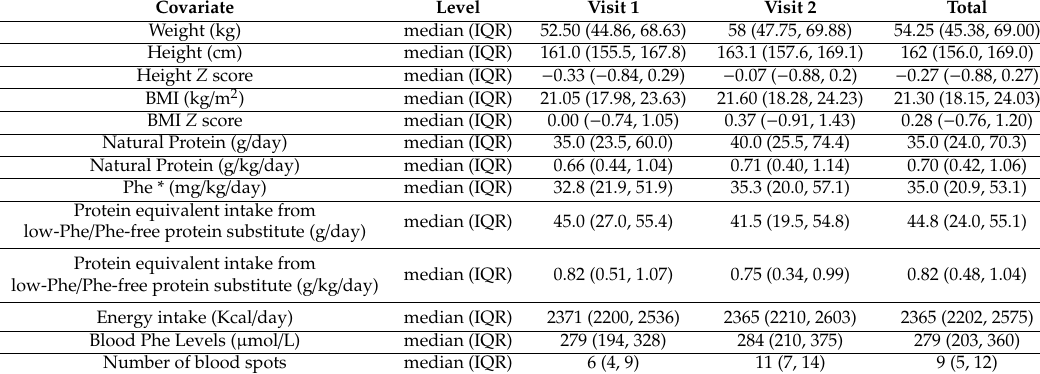
Table 2. Anthropometric measurements, dietary intake data and blood Phe levels at baseline (visit 1) and visit